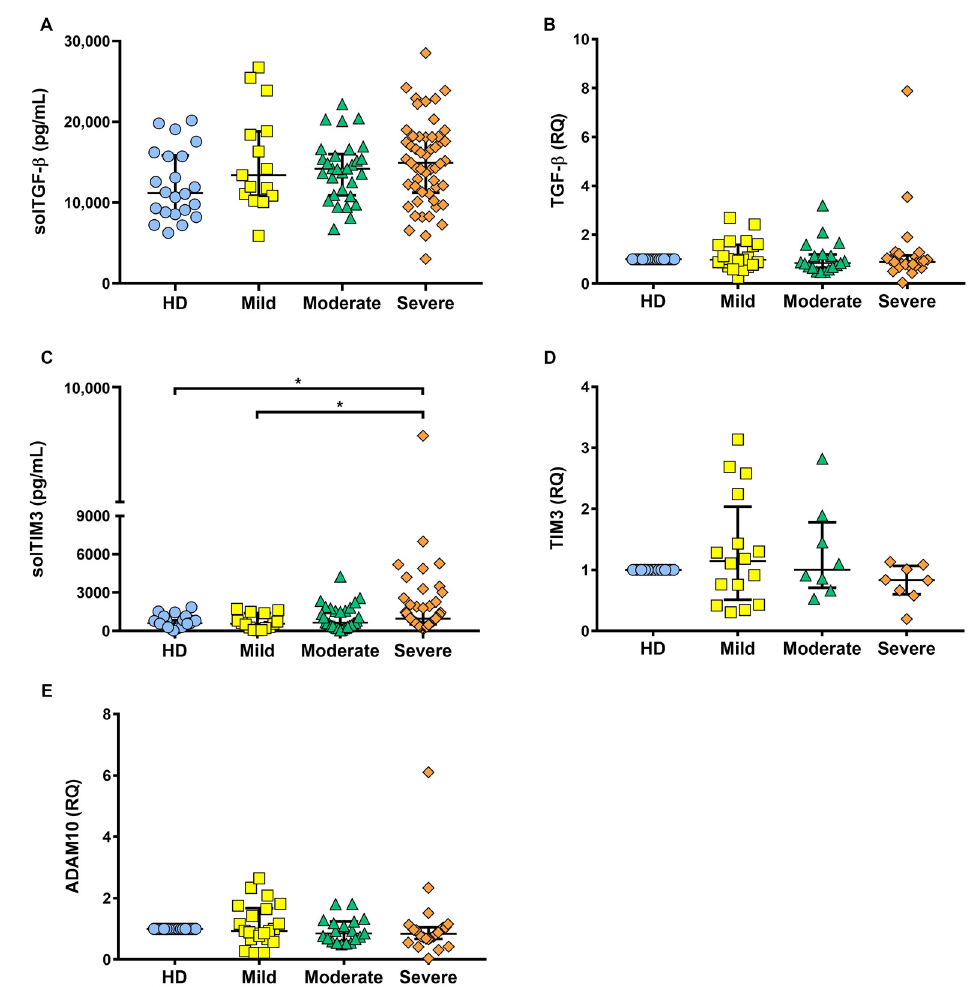
Figure 5. solTIM3 is increased in COVID-19 patients but not TGF- β . The soluble forms of TGF- β and TIM3 were measured by ELISA sandwich assay ( A , C , respectively). As compared to the healthy donors (HD), only solTIM3 was significantly increased in COVID-19 patients. At the transcriptional level as evaluated by qRT-PCR, no differences were found in the relative quantification (RQ) of TGF- β , TIM3, and ADAM10 ( B , D , E , respectively) between HD and the group of COVID-19 patients (mild, moderate, and severe); (solTGF- β : HD n = 22, mild n = 15, moderate n = 30, and severe n = 53;